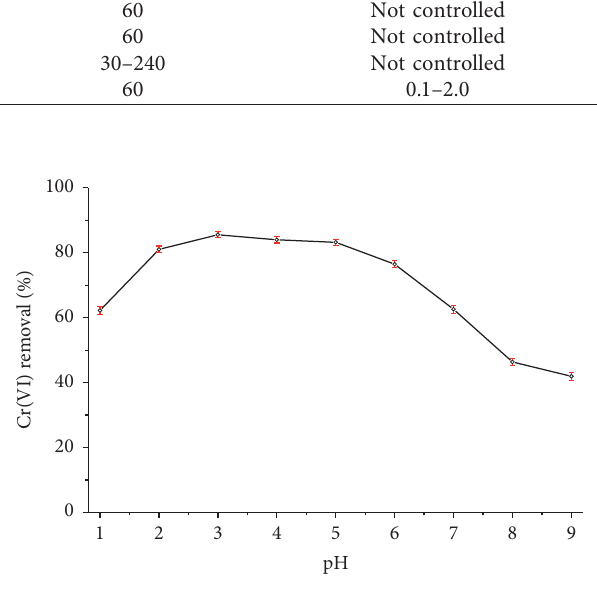
Figure 3: Effect of pH on removal of Cr(VI) using organo- bentonite. Conditions: C i � 50mg/L, V � 50 mL, T � 20 ° C, stirring